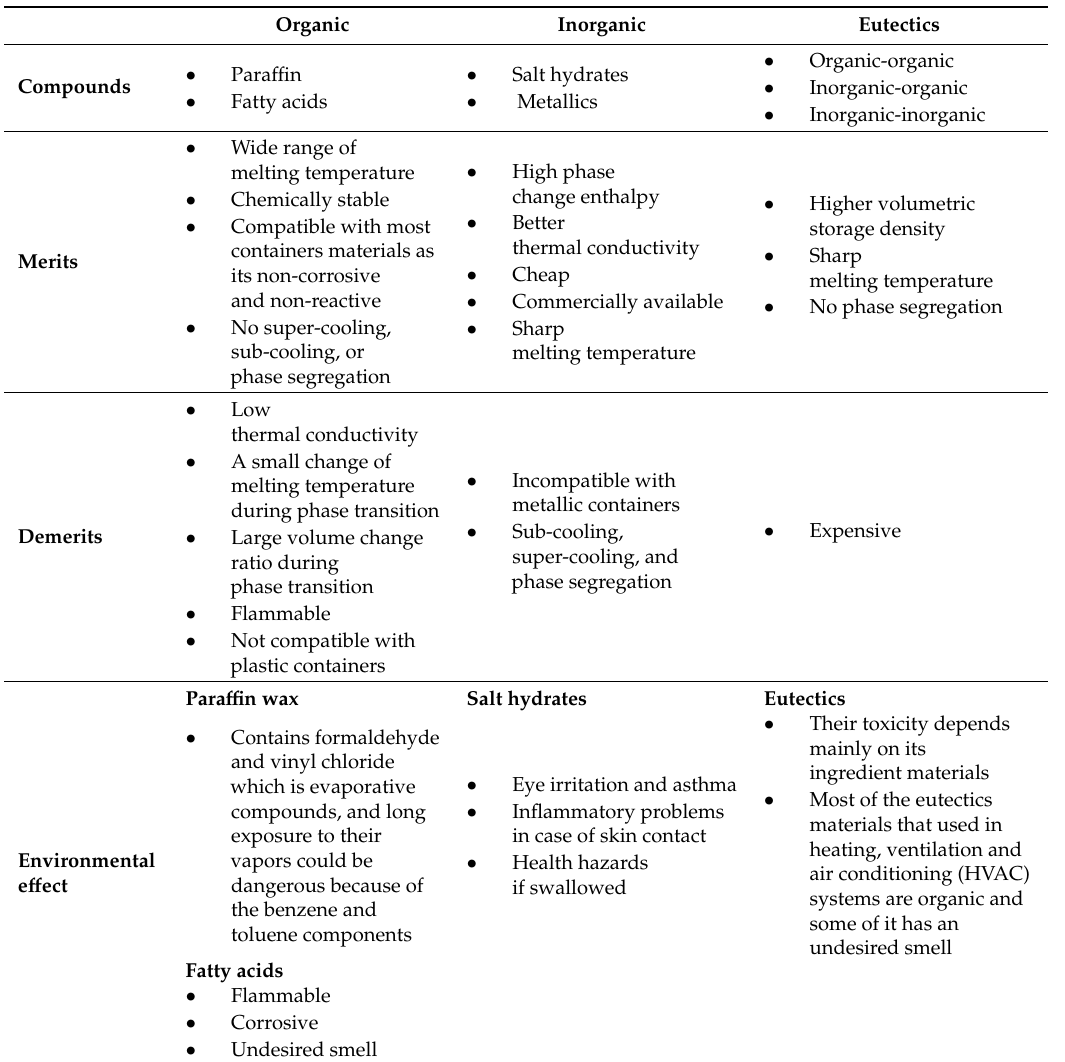
Table 1. PCM characteristics and environmental e ff